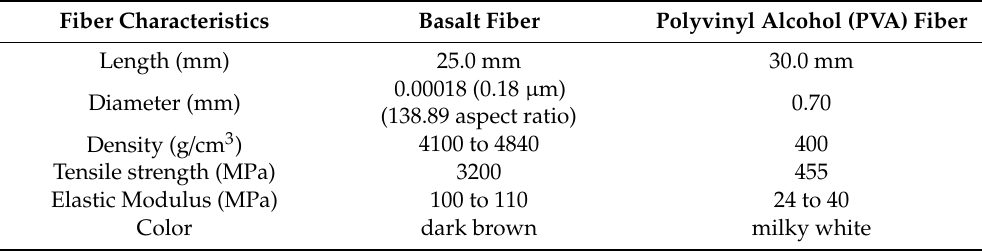
Table 1. Properties of